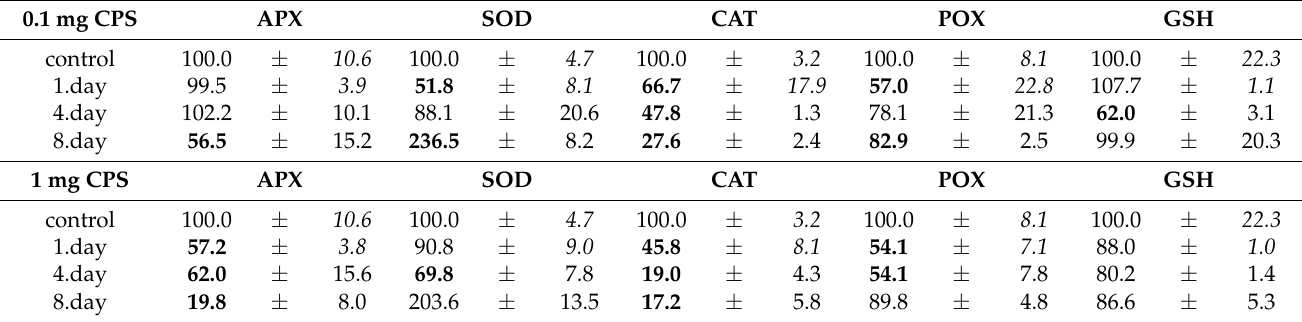
Table 1. Activity of antioxidant enzymes (APX—ascorbate peroxidase; SOD—superoxide dismutase; CAT-catalase; POX—peroxidase; GST—glutathione-S-transferase) in poplar cells after 1, 4, and 8